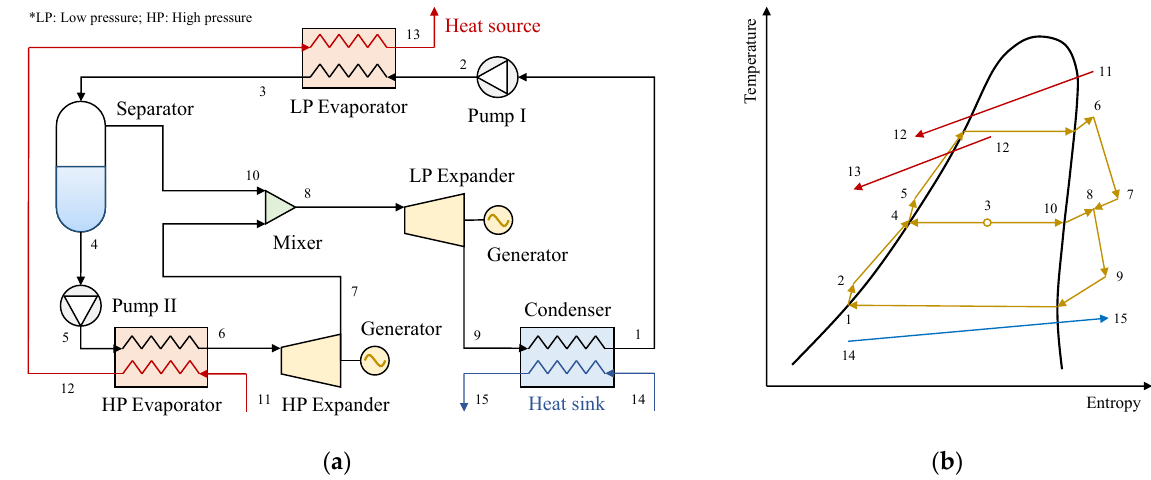
Figure 16. Diagrams of partial evaporating multi − pressure ORC: ( a ) system configuration; and ( b ) cycle process.